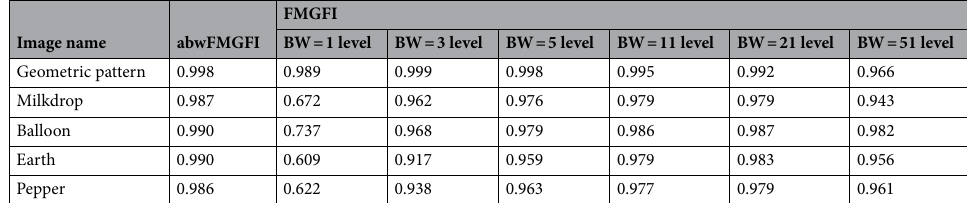
Table 14. Comparison of the SSIM values of each sample image filtered using the variable level of BW of FMGFI (regarding edge preservation performance).